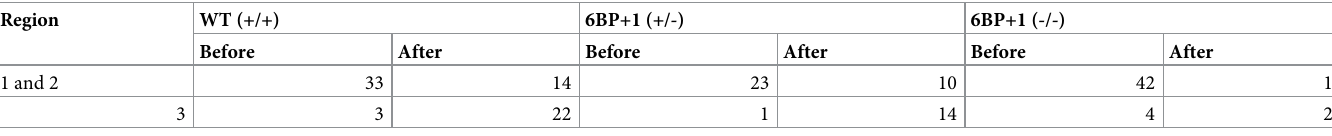
Because of a lack of LWS cone physiology, OMR responses to red/black drifting gratings were not expected in 6BP+1 homozygous mutants, and in fact were not found (Fig 12). Of 16 larvae in region 1 of the mutant plate (Fig 12C) 16 remained after stimulation with a red/black grating (Fig 12C’). In region 3, there was 1 larva before and after stimulation. The combined data from both trials are consistent with a lack of mutant OMR for red/black gratings (Fisher Exact Test, N = 46, P > 0.99). WT and heterozygous mutant larvae (Fig 12A, 12A’, 12B and 12B’) showed significant OMR behavior under the same conditions (Fisher Exact Test, +/+, N = 36, P < 0.01; +/-, N = 24, P < 0.05). The combined distributions are shown in Table 3.